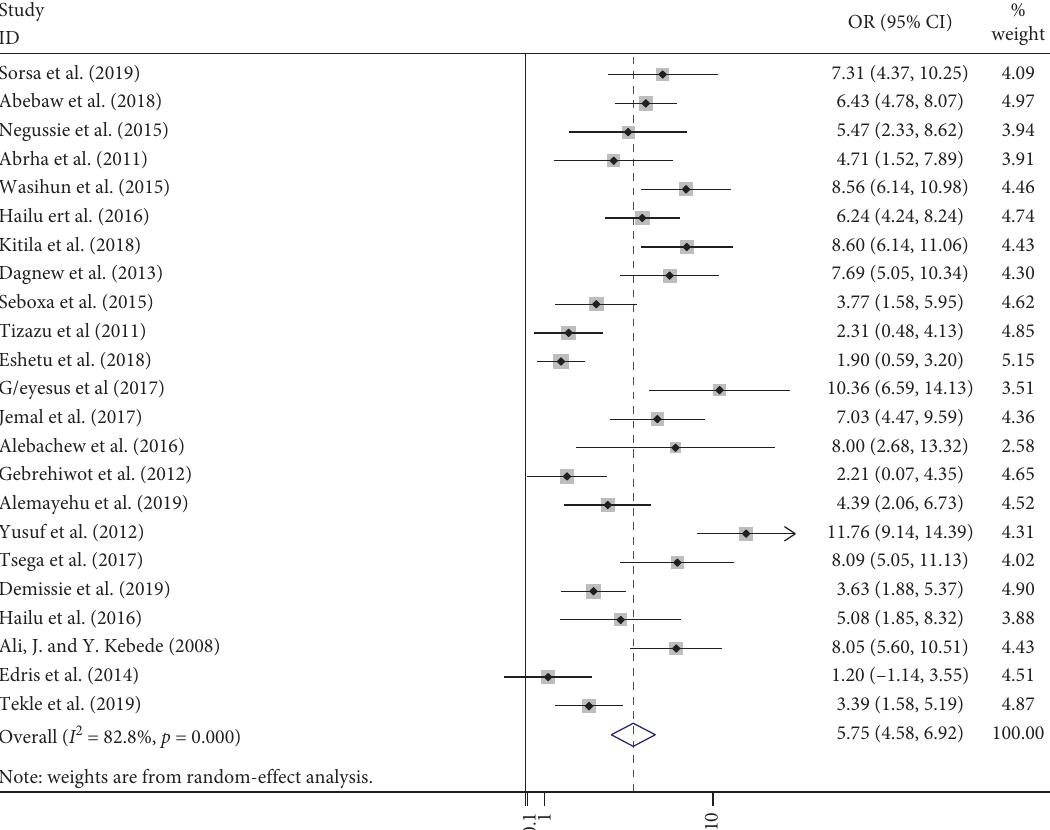
Figure 5: Forest plot showing the pooled prevalence CoNS bacterial isolates among patients with suspected bloodstream infections in